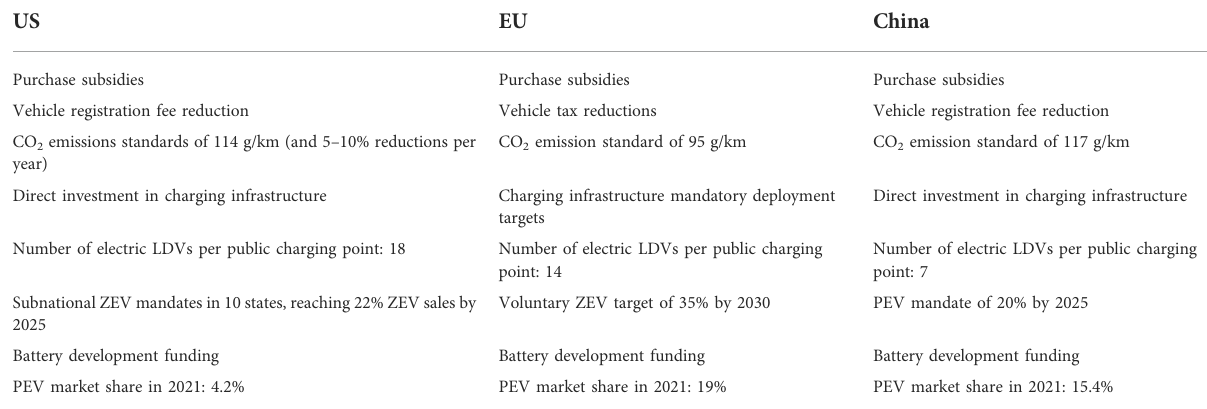
TABLE 3 Summary of inventory of public policies to promote light-duty passenger electric vehicle sales in the US, EU, and China, with 2021 PEV market shares (IEA, 2021b). US EU Purchase